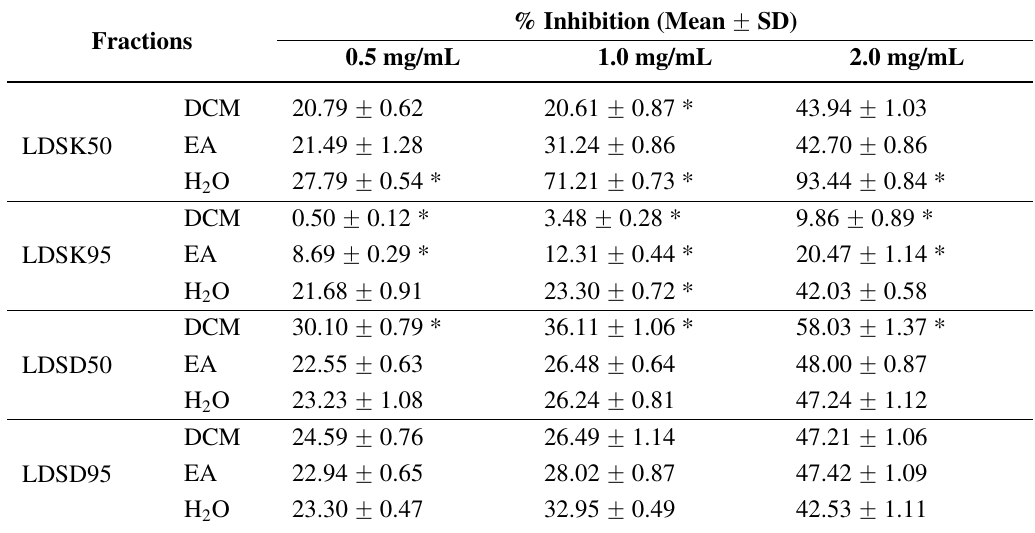
Table 2. Percent inhibition of 2-deoxyribose (2-DR) degradation of the 12 L. domesticum fractions by deoxyribose